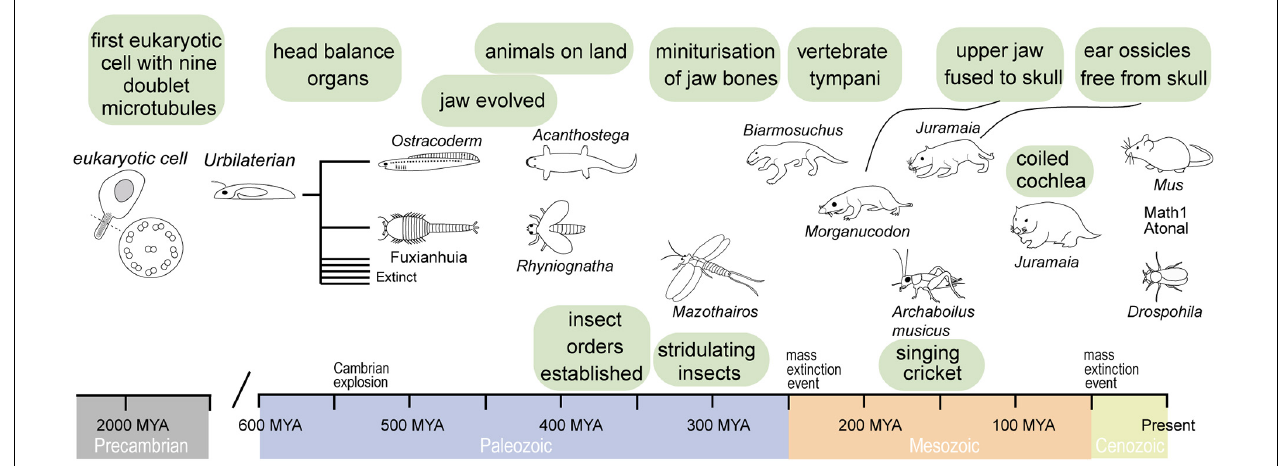
FIGURE 1 | Timeline of evolution of important ear structures in vertebrates and invertebrates that have a common ancestor in the Urbilaterian. This bilateral organism probably had already mechano-sensitive cells.